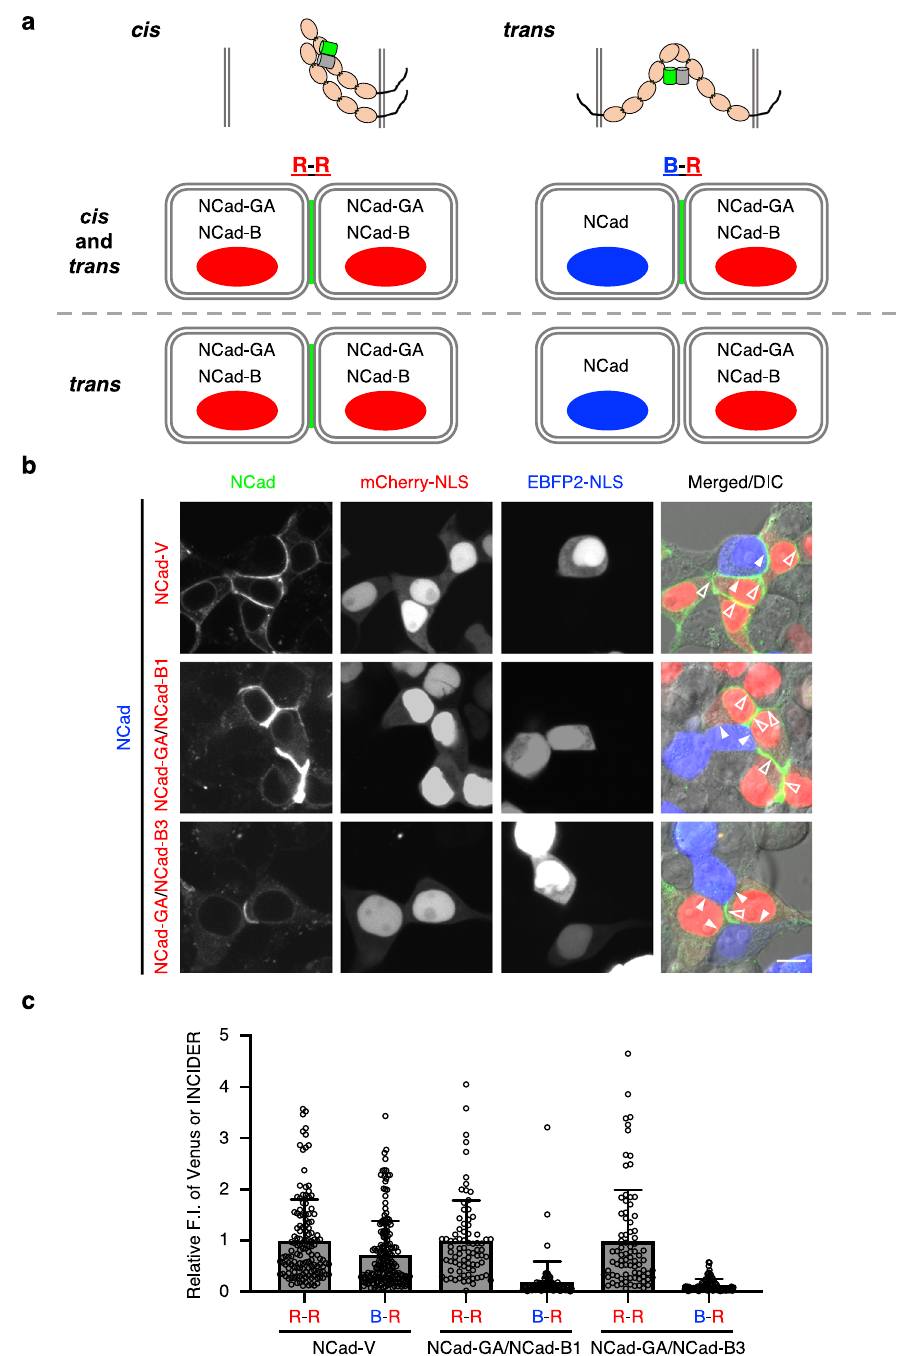
Fig. 2 Trans-interface visualized by INCIDERs. a Schematic representation of the co-culture experiment between cells co-expressing INCIDER components (NCad-GA/NCad-B) and cells expressing NCad without a fl uorescent protein. b HEK293T cells expressing the indicated constructs were co- cultured and observed using a confocal microscope. mCherry-NLS and EBFP2-NLS are hallmarks of NCad-V or NCad-GA/NCad-B and NCad without fl uorescent protein-expressing cells, respectively. Cell adhesion sites between red cells and between blue cells and red cells are described as R-R and B-R, respectively. Closed and open arrowheads indicate cell adhesion sites between mCherry-positive cells/EBFP2-positive cells (B-R) and mCherry-positive cells (R-R), respectively. Scale bar, 10 μ m. c Fluorescence intensities of Venus and INCIDERs at R-R and B-R cell adhesion sites were quanti fi ed and normalized by the mean values of R-R cell adhesion sites. Data are presented as relative mean values ± SD. 137 (R-R of NCad-V), 184 (B-R of NCad-V), 80 (R-R of INCIDER-1), 77 (B-R of INCIDER-1), 81 (R-R of INCIDER-3), and 93 (B-R of INCIDER-3) cell adhesion sites were analyzed from three independent fewer signals were detected at the cell – cell interfaces between to NCad WT -V (Fig. 3c). We co-cultured L cells stably expressing NCad mut -GA-expressing and NCad mut -B-expressing cells (Fig. 3c, NCad mut -GA and NCad mut -B, respectively. Although ddGFP signals were detected at the cell adhesion sites between NCad WT - d). It is possible that a difference in membrane localization ef fi - GA-expressing and NCad WT -B-expressing cells, signi fi cantly ciency between NCad WT and NCad mut contributed to a difference